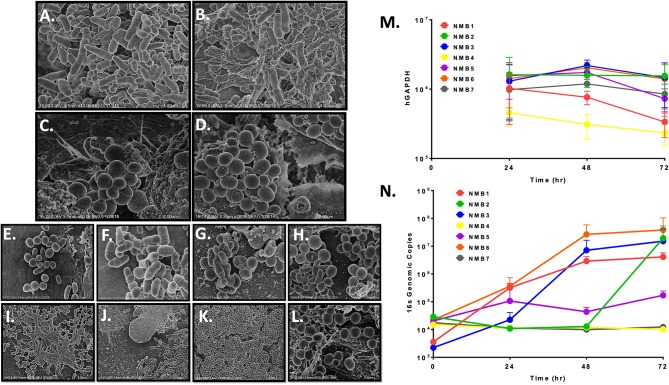
Representative NEC multilayers supported colonization of microbial communities as revealed by SEM imaging at 5–20 k magnification (A–L) and qPCR (M,N). A–B. NEC03 multilayers seeded with NMB from a healthy donor revealed numerous bacterial cell morphologies, predominantly rods and cocci. C–D. NEC03 multilayers seeded with NMB from a donor who recently received antibiotic therapy revealed predominantly clustered cocci, consistent with Staphyloccocus spp. (E–J) NEC03 multilayers seeded with NMB were examined at 4 (E,F), 24 (G,H) and 48 h (I–J). Proliferation and stabilization of bacterial communities were most evident by 24 and 48 h, with extracellular polymeric substances deposition observed at 48 h (I). (K,L). NEC02 multilayers seeded with S. aureus displayed confluent colonization by the bacteria. (M) Health of the NEC02 was maintained in the presence of 7 distinct NMB over 72 h as indicated by genomic counts (hGAPDH). (N) NEC02 multilayers supported bacterial colonization by distinct NMB over time.